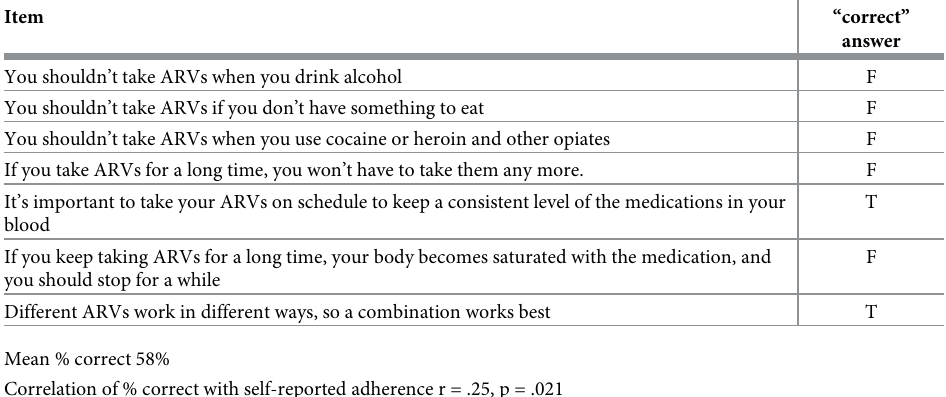
Table 3. ARV knowledge quiz.